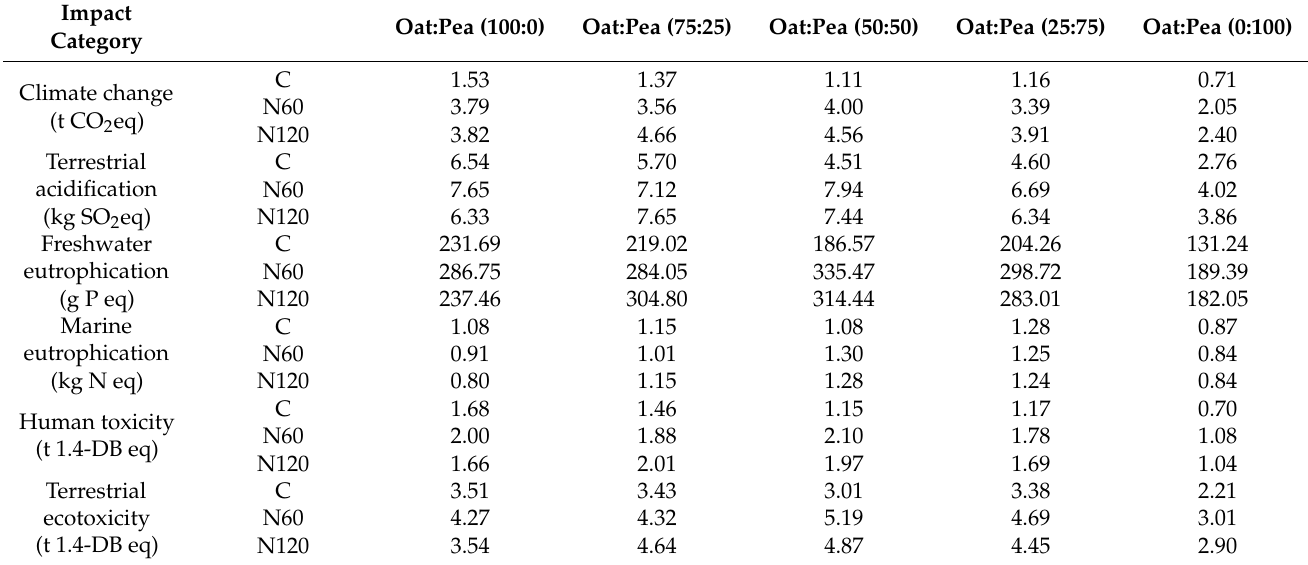
Table 3. Environmental impact per land demand for generating the same grain N